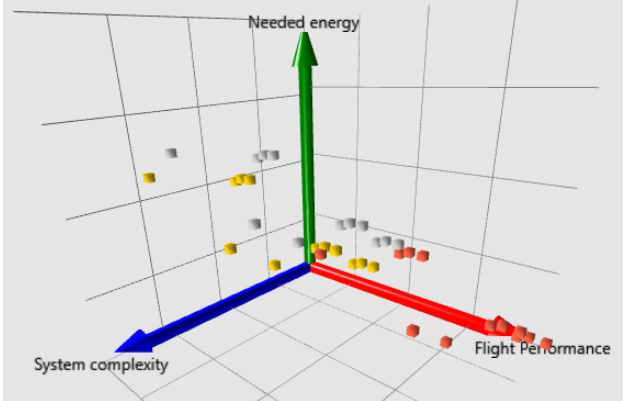
Figure 9. Option distribution for the morphable wing section attribute. Gray—near wingtips; yellow—near wing root; red—both or entire wing. The solution space is zoomed for a better visibility of all